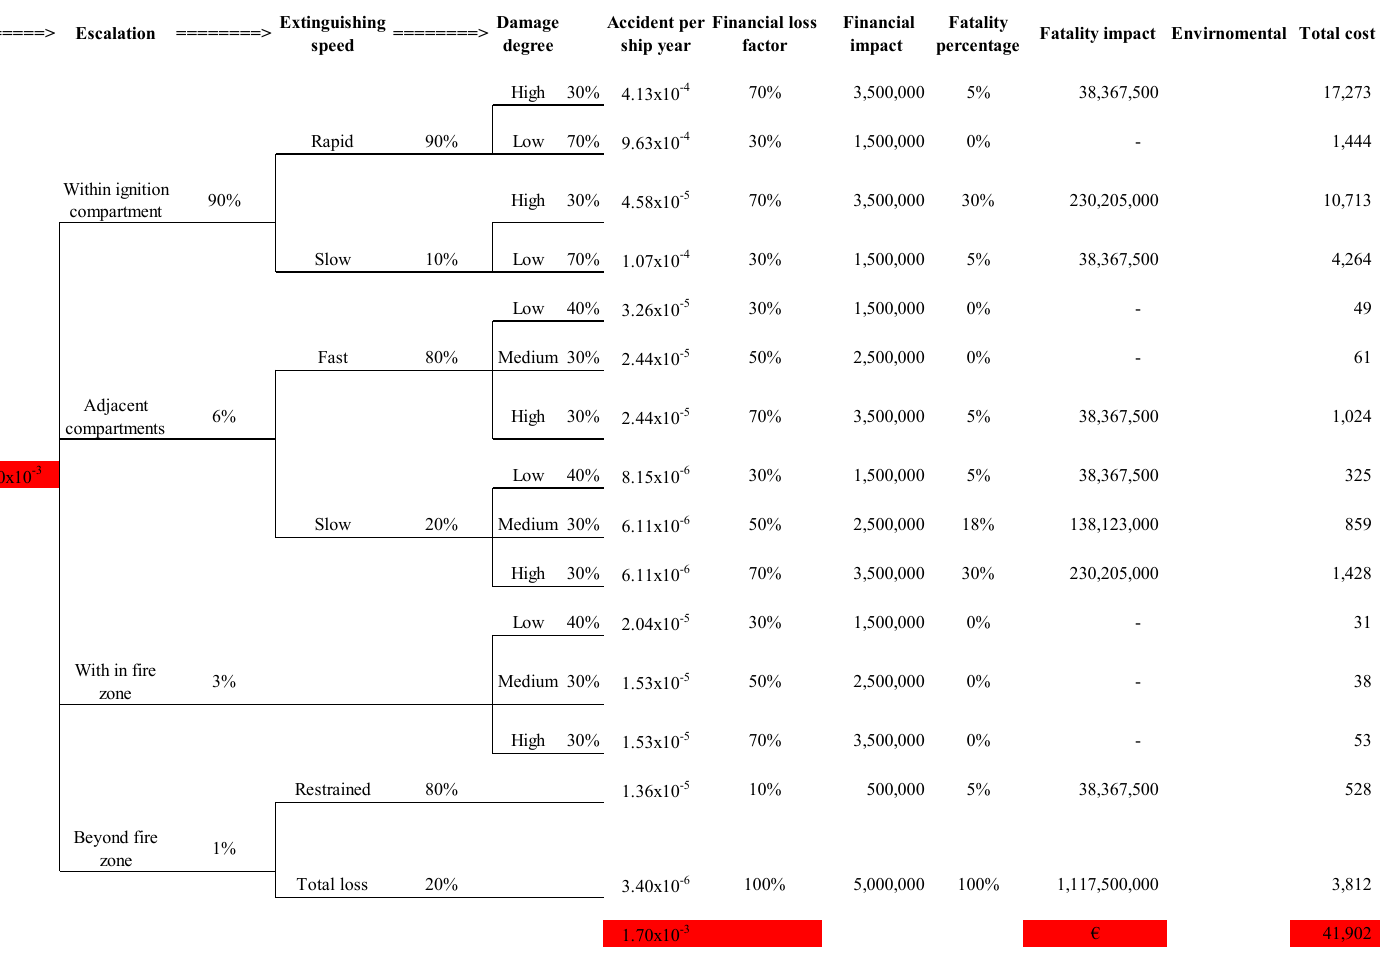
Figure 19. Event tree analysis of fire for the ferry in this